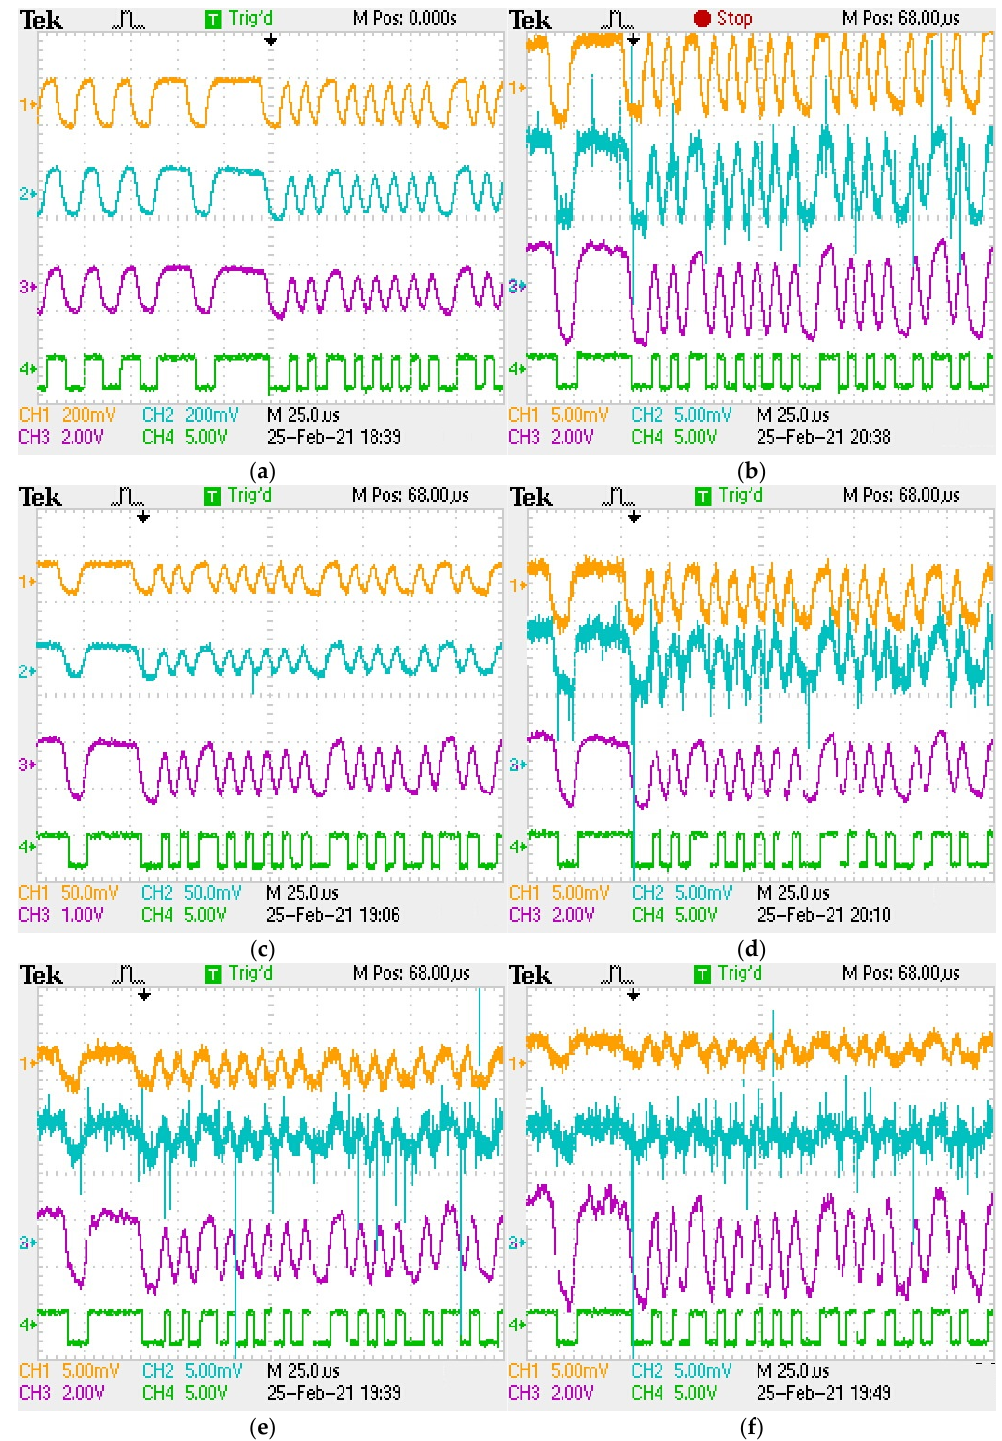
Figure 10. Oscilloscope print screens showing the signal reconstruction process at the level of the different blocks of the VLC receiver: Channel 1 (orange) shows the output of the optical receiver for a 40 dB gain; Channel 2 (cyan) shows the output of the band-pass filter; Channel 3 (purple) shows the output of the amplification block; Channel 4 (green) shows the reconstructed signal which will be used in the data decoding process: ( a ) vehicles on the same lane with 4 m inter-vehicle distance; ( b ) vehicles on adjacent lanes with 4 m inter-vehicle longitudinal distance (close to the minimum communication distance); ( c ) vehicles on the same lane at 10 m distance; ( d ) vehicles on adjacent lanes at 10 m inter-vehicle longitudinal distance; ( e ) vehicles on the same lane at 35 m; and ( f ) vehicles on adjacent lanes at 35 m inter-vehicle longitudinal distance. One can see that as the distance increases, the misalignment effect becomes less